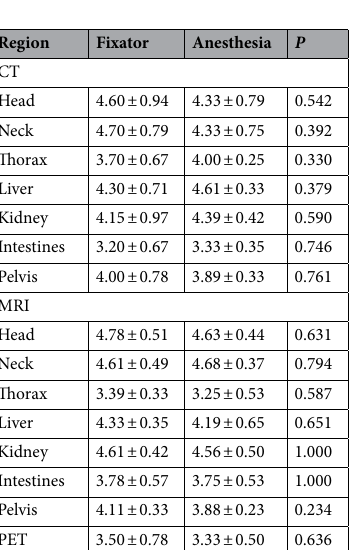
Figure 2. The SUV change curve of the different organs in the two groups at different time points, which shows that the SUVs of the brain (a) , lung (b) , liver (c) , kidney (d) , and muscle (e) gradually fell over time, and the reduction trends in the fixator group and the anesthesia group were similar.